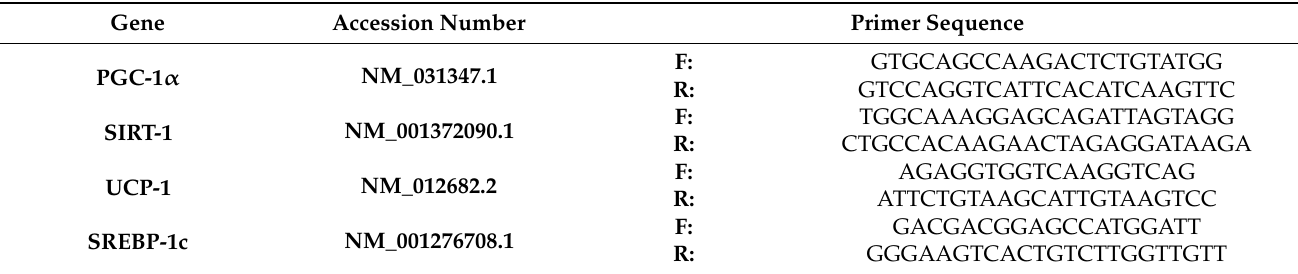
Table 1. Primer sets of the gene expression of PGC-1 α , SIRT-1, UCP-1, SREBP-1c, TNF- α , and